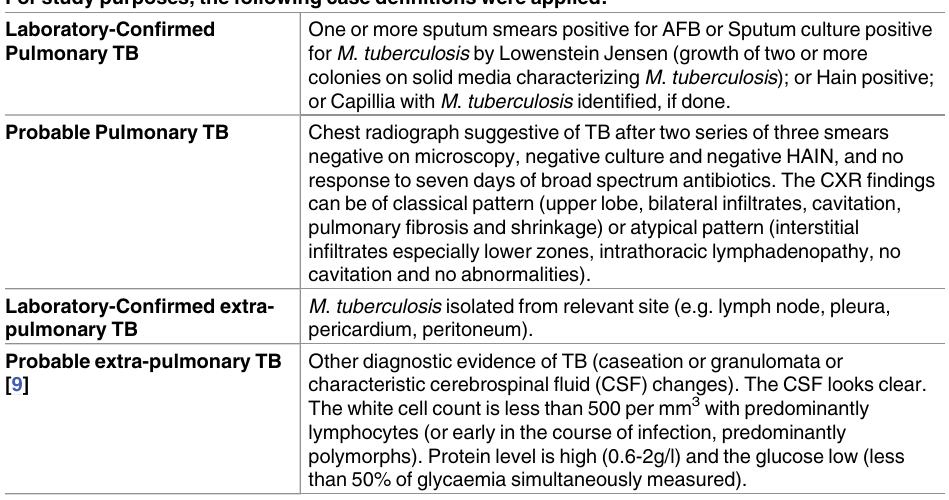
Table 1. TB Case